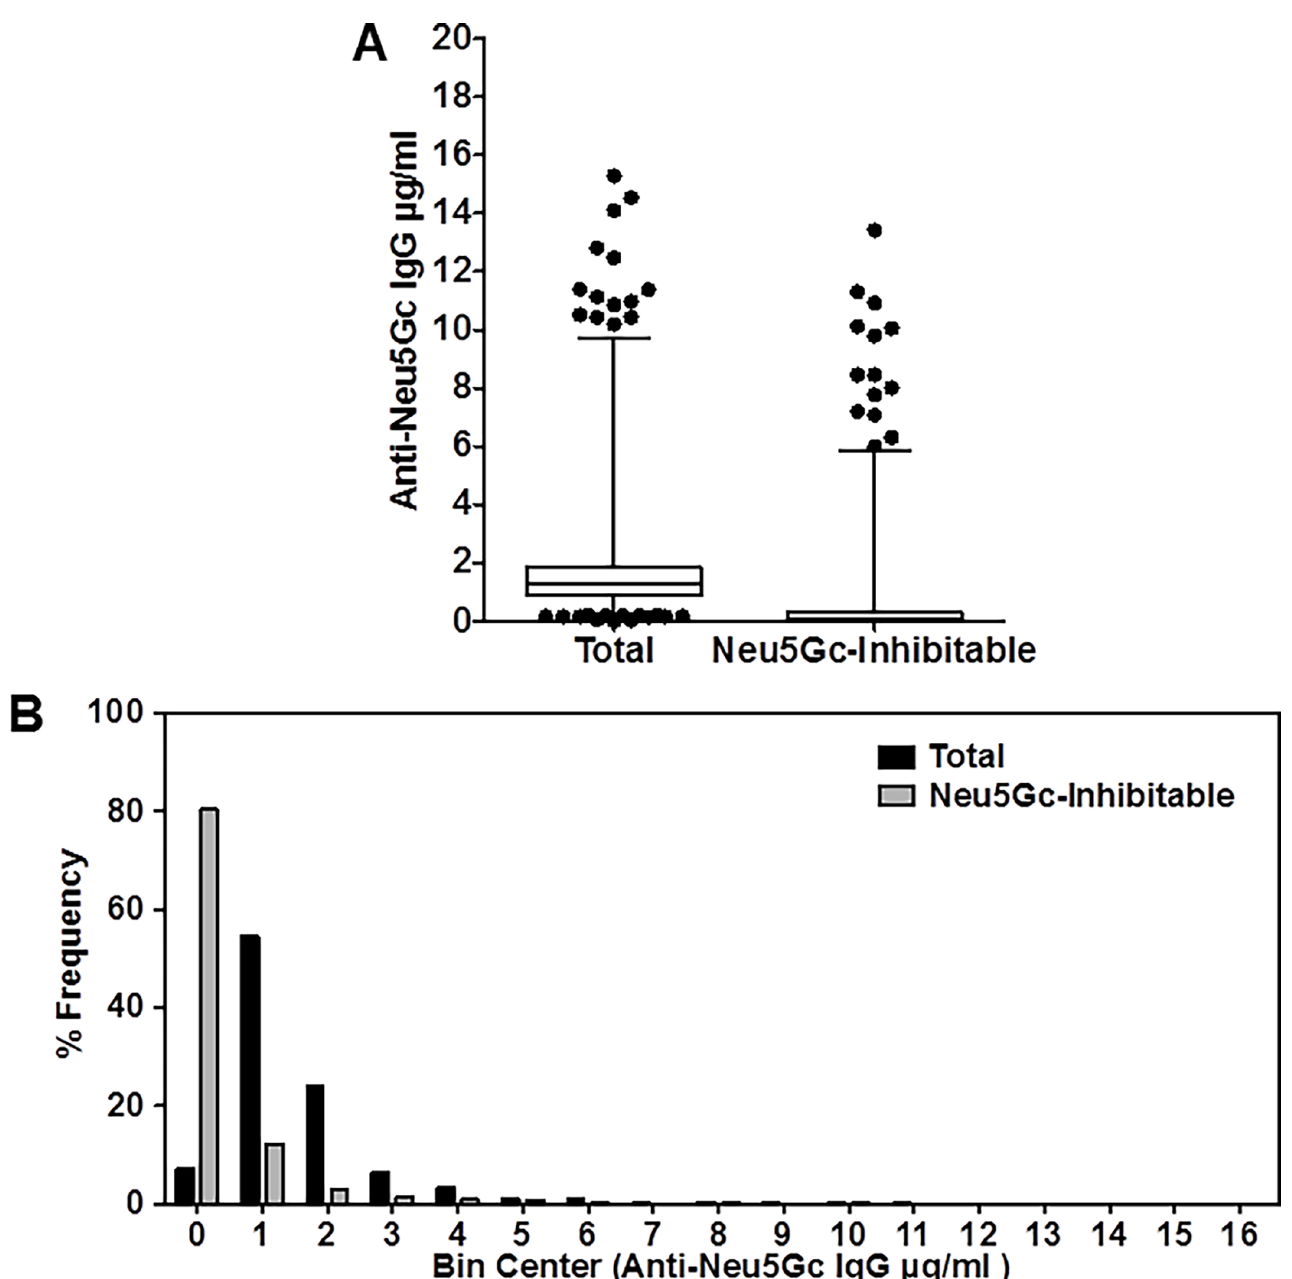
Fig 4. Distribution of Anti-Neu5Gc IgG titers against a mixture of epitopes in the EPIC-Norfolk cohort. (A) Serum anti-Neu5Gc IgG antibodies in the EPIC-Norfolk population assayed as in Fig 1. Serum total and inhibitable anti-Neu5Gc IgG levels were quantified by ELISA using wild type mouse serum that contains naturally occurring Neu5Gc containing epitopes as the target antigen (N = 1469). The mean total IgG was 1.7 μg/ml (SD±1.6) and the mean inhibitable IgG was 0.4 μg/ml (SD±1.2). Total and “inhibitable” anti-Neu5Gc IgG were defined as in Fig 1. (B) The distribution of levels of anti-Neu5Gc IgG was evaluated by dividing all the samples into 16 bins, in steps of 1 μg/ml each, and the frequency of number of tested samples in each bin described as bar charts for both total (black) and inhibitable (grey) IgG values.